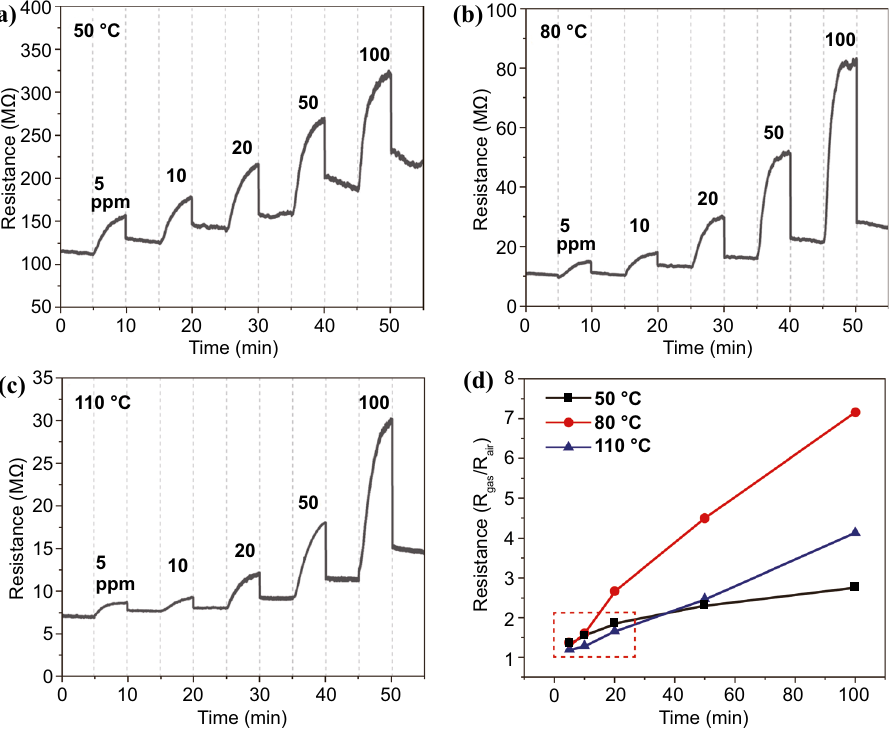
Fig. 3 Resistance variation of BG sensor to different concentrations of ammonia at a 50 °C, b 80 °C, and c 110 °C and d correlation between gas response and ammonia concentration at different temperatures